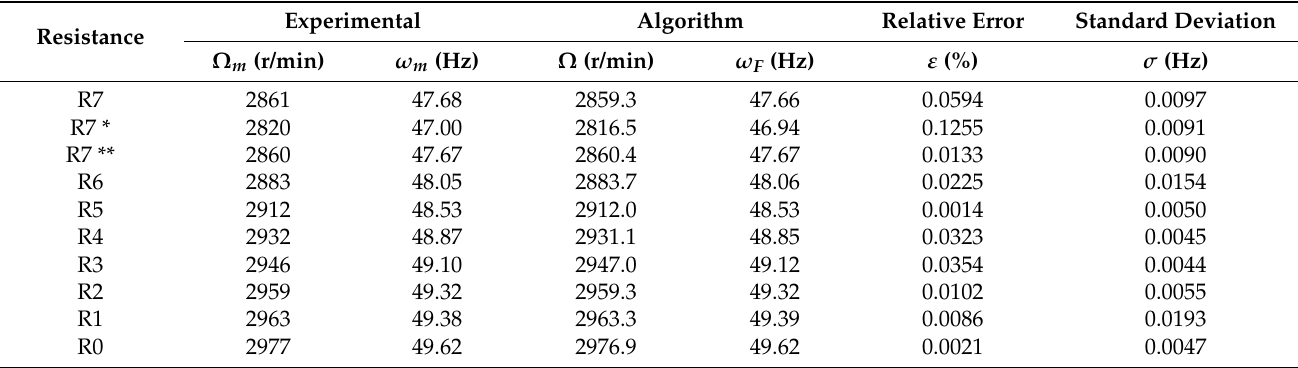
Table 6. DC generator coupled to the motor shaft: estimated speeds and frequencies, relative errors, and standard deviations. Experimental Algorithm Relative Error Resistance